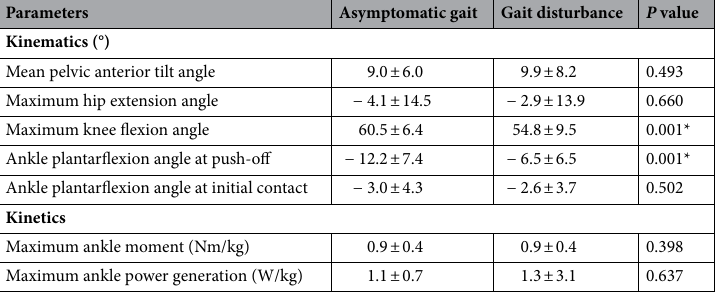
Table 3. Comparison of preoperative kinetic and kinematic parameters between groups. Negative values indicate hip extension and ankle plantarflexion. * P < 0.05.